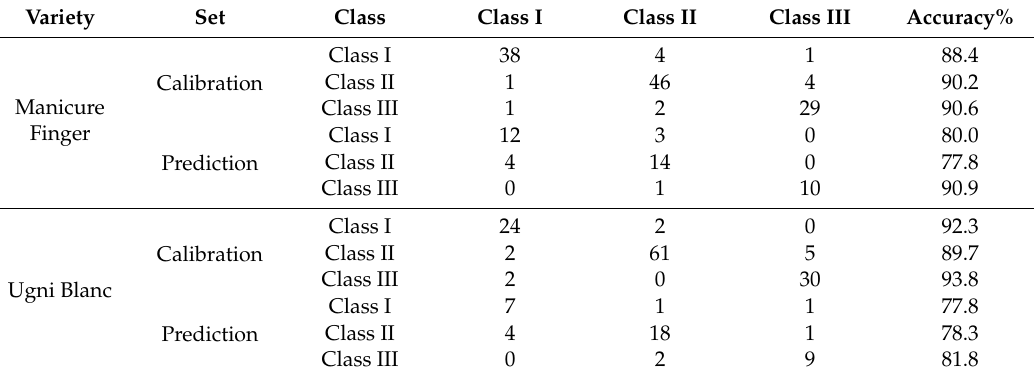
Table 4. Discrimination accuracies of two varieties from di ff erent classes using partial least squares discrimination